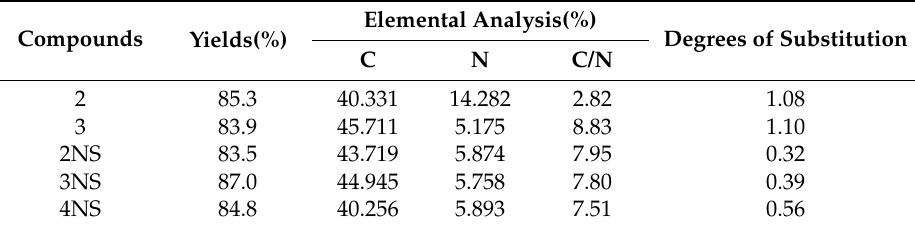
Table 1. Yields and the degrees of substitution of the inulin